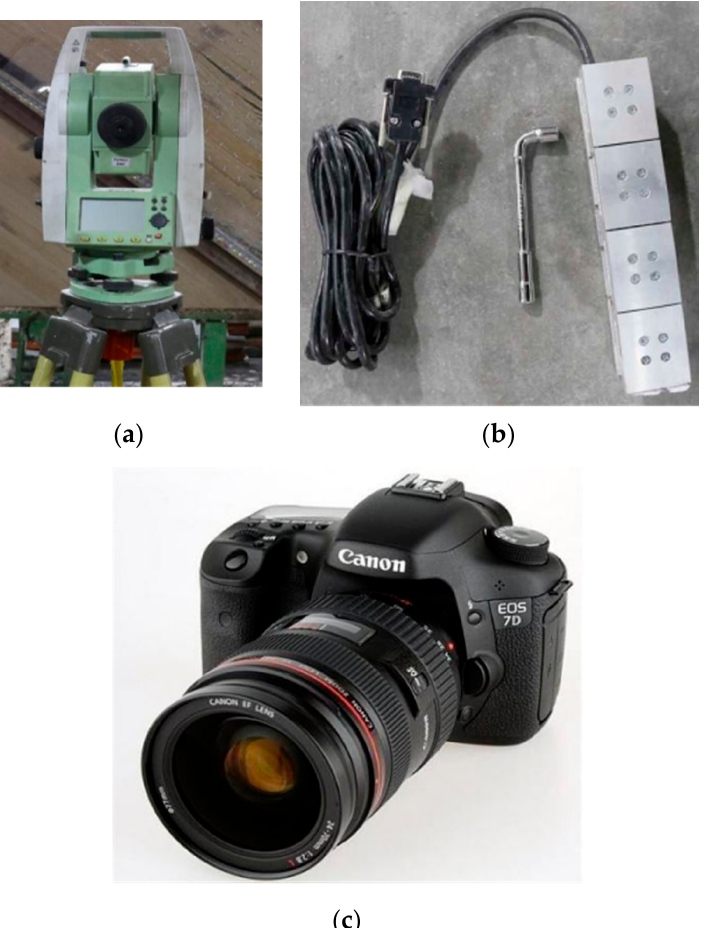
model test. ( a ) Optical total station; ( b ) Simple support; ( c ) High-speed camera.